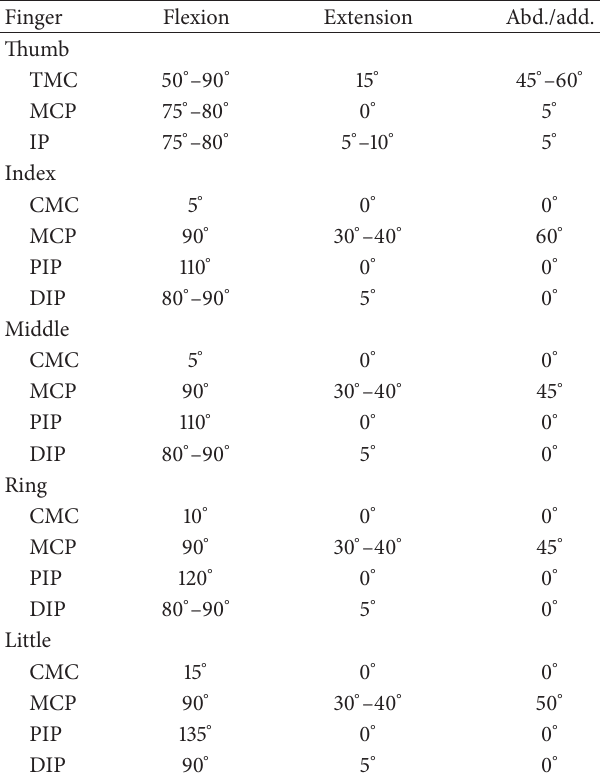
Table 6: Statics constraints